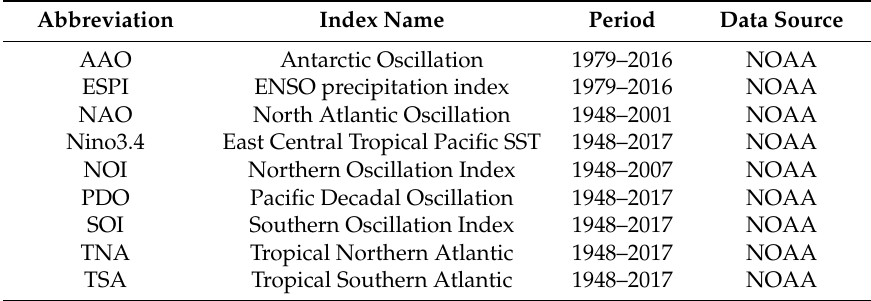
Table 1. Description of the global climate variability (GCV) indices used in the study. NOAA is the abbreviation of National Oceanic and Atmospheric